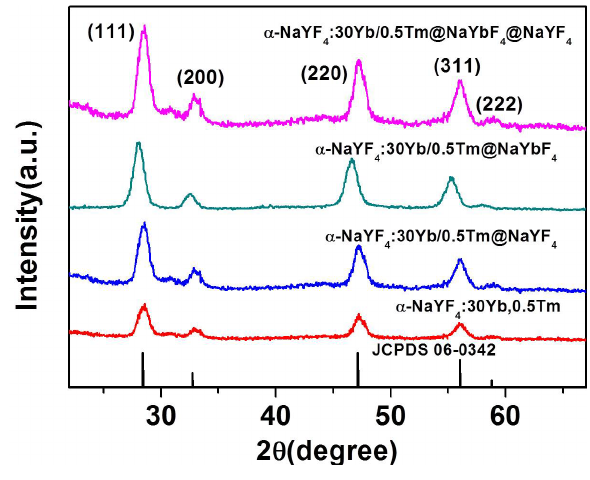
: 30%Yb 3+ , 0.5%Tm 3+ nanoparticles, 4 : 30%Yb 3+ , 0.5%Tm 3+ )/NaYF nanoparticles, the active 4 4 : 30%Yb 3+ , 0.5%Tm 3+ )/NaYbF nanoparticles, and the active 4 4 : 30%Yb 3+ , 0.5%Tm 3+ )/NaYbF /NaYF 4 4 4